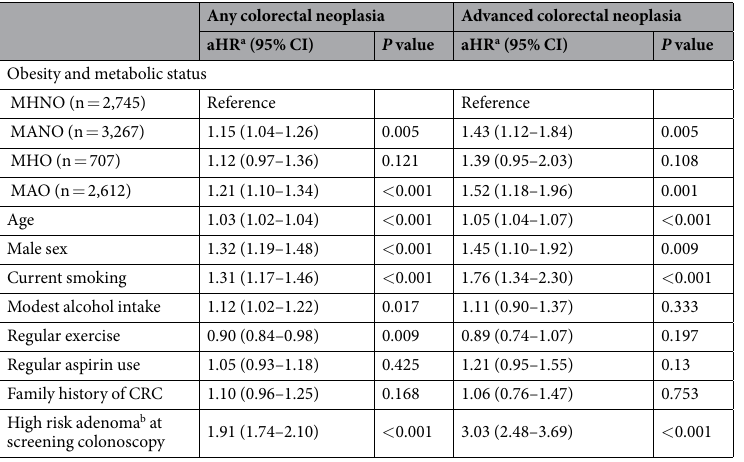
Table 2. The risk of metachronous colorectal neoplasia in multivariate analyses. a Estimated from Cox proportional hazard models adjusted for age, sex, smoking status, alcohol intake, regular exercise, regular aspirin use, family history of colorectal cancer, and high risk adenoma at screening colonoscopy. b High risk adenoma includes any adenoma larger than 1 cm, 3 or more adenomas, any adenoma with a villous component, or high-grade dysplasia. a HR, adjusted hazards ratio; CI, confidence interval; MHNO, metabolically healthy non-obese; MANO, metabolically abnormal non-obese; MHO, metabolically healthy obese; MAO, metabolically abnormal obese; CRC, colorectal cancer.